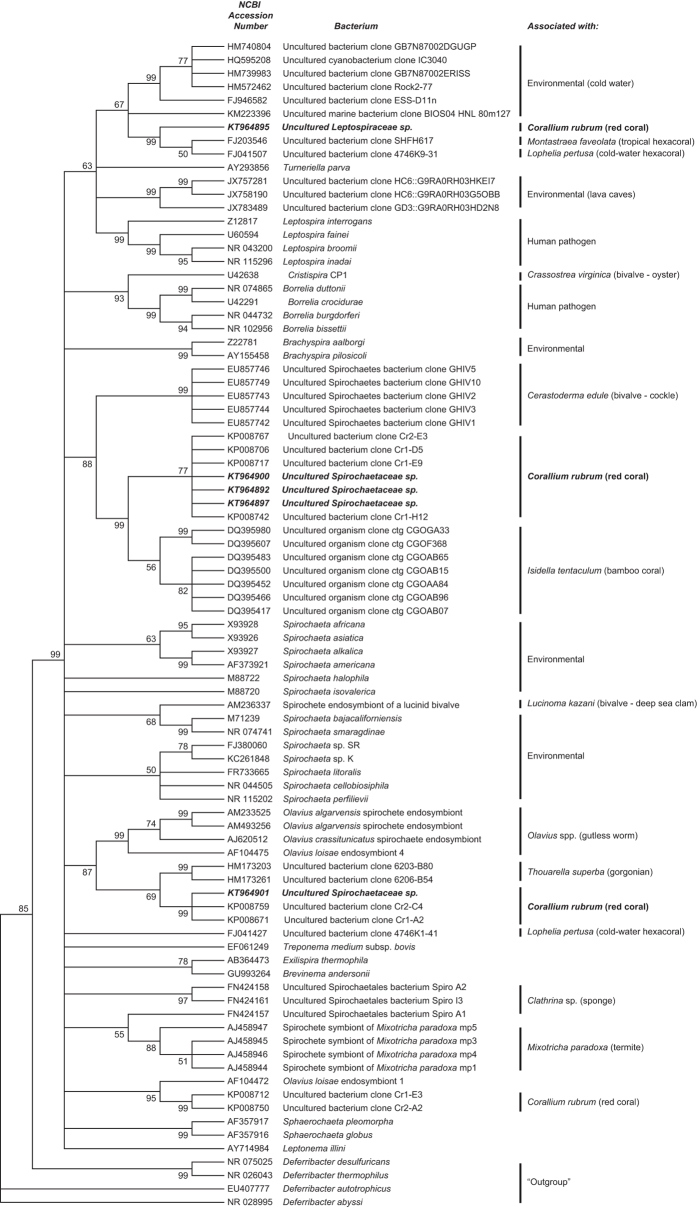
Phylogeny of Spirochaetes.A 16S ribosomal RNA reconstruction of the Spirochaetes created based on the maximum parsimony model. Percentages of 1000 bootstrap replicates are indicated next to the tree nodes if they are >50%. Sequences from the present study are in bold and italic. The tree is rooted using sequences from the phylum Deferribacter as the outgroup.